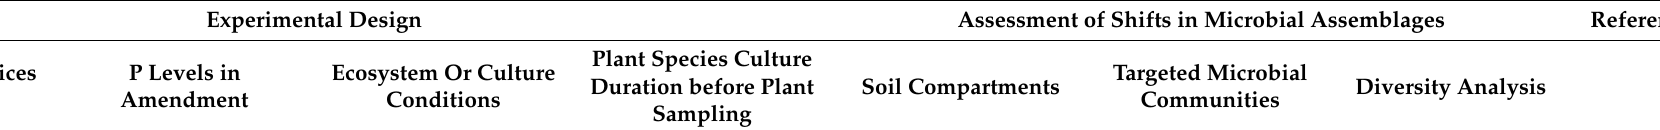
Table 1. Influence of P towards soil microbiome: Diversity of some selected experimental designs developed in microbial community profiling for assessing P-dependant